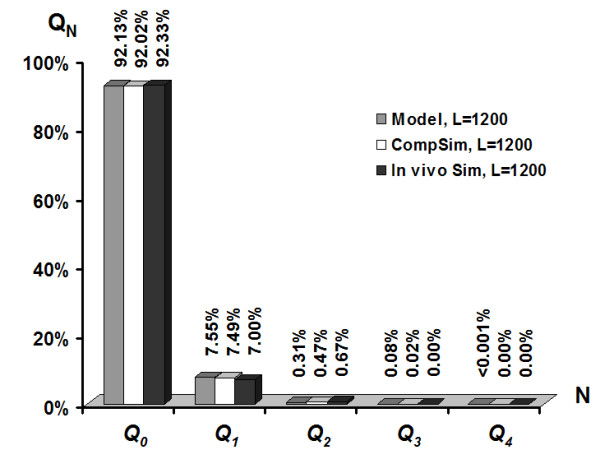
Probability to find various numbers of quasi-ditags (QN) in the same nucleotide sequence of the given length (L = 1200 bp). L, sequence length; Model, mathematical modeling; CompSim, computer simulation (1,000,000 simulations); In vivo Sim, fragments of S. Cerevisiae chromosome (300 simulations).